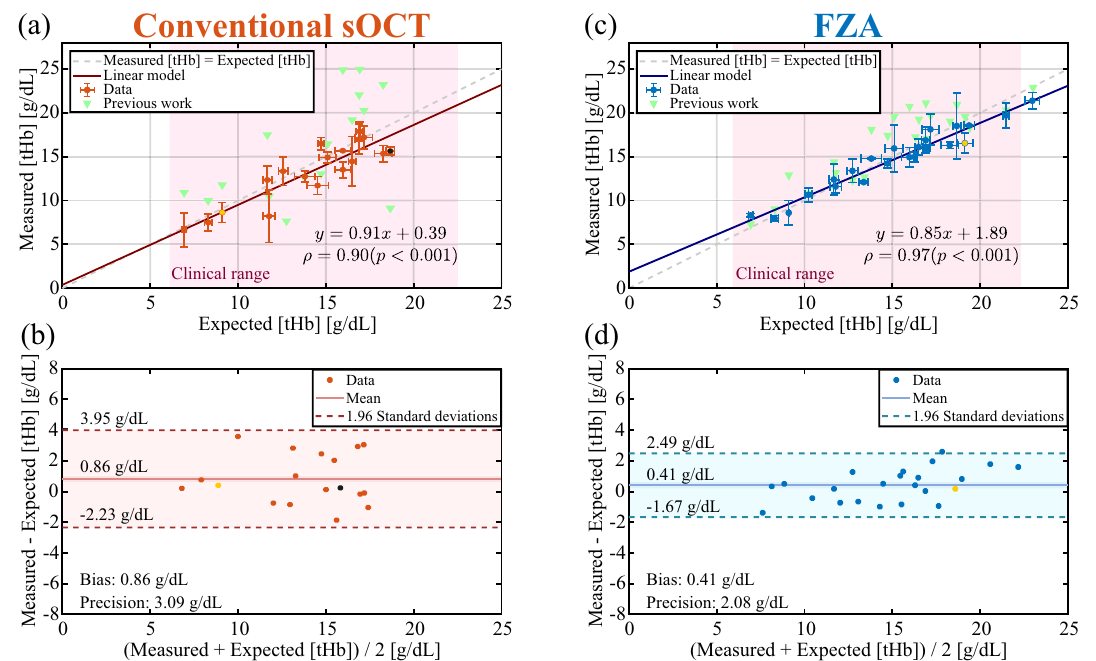
Figure 5. Total haemoglobin concentrations retrieved after processing all data sets. (a) Measured [tHb] as a function of expected [tHb] with conventional sOCT (mean value ± SD) for all measurements and (b) Bland–Altman plot for the same data from which we obtain a bias of 0.86 g/dL and a precision of 3.09 g/dL. (c) Measured [tHb] as a function of expected [tHb] with FZA for all measurements and (d) Bland–Altman plot for the same data, showing a bias of 0.41 g/dL with a precision of 2.08 g/dL. The points filled with yellow had one excluded measurements, while those filled in black had two exclusions. For comparison purposes, data form our previous work 17 is included in (a,c) . For visualization clarity, the SDs of previous data are omitted from (a,c) , and previous data points not included in (b,d) .